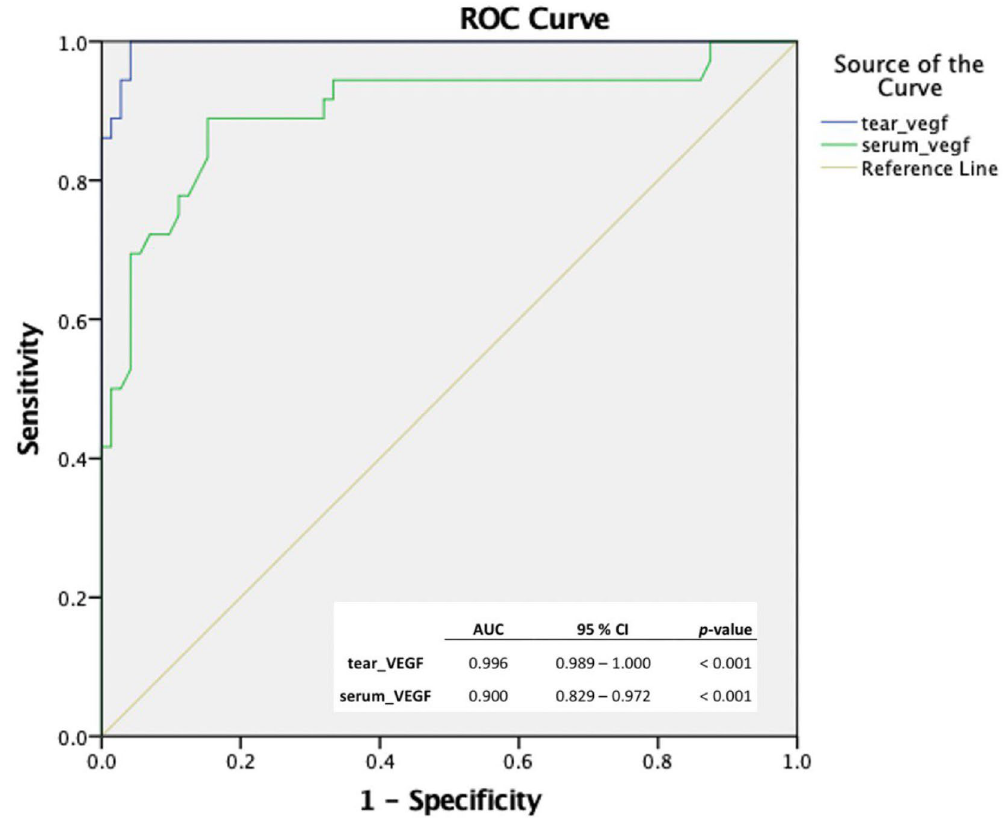
Figure 1. ROC curves represent predictive value of VEGF level in determining AMD severity. The tear VEGF curve shows an excellent AUC (0.996), indicating highly sensitive and specific value of the tear VEGF as a predictor for AMD severity. There are diagonal segments in the serum VEGF curve produced by ties between the positive and the negative actual state group; and statistics may be biased despite the excellent AUC (0.900) observed. ROC Receiver operating characteristic, VEGF Vascular endothelial growth factor, AMD Age-related macular degeneration, AUC Area under ROC